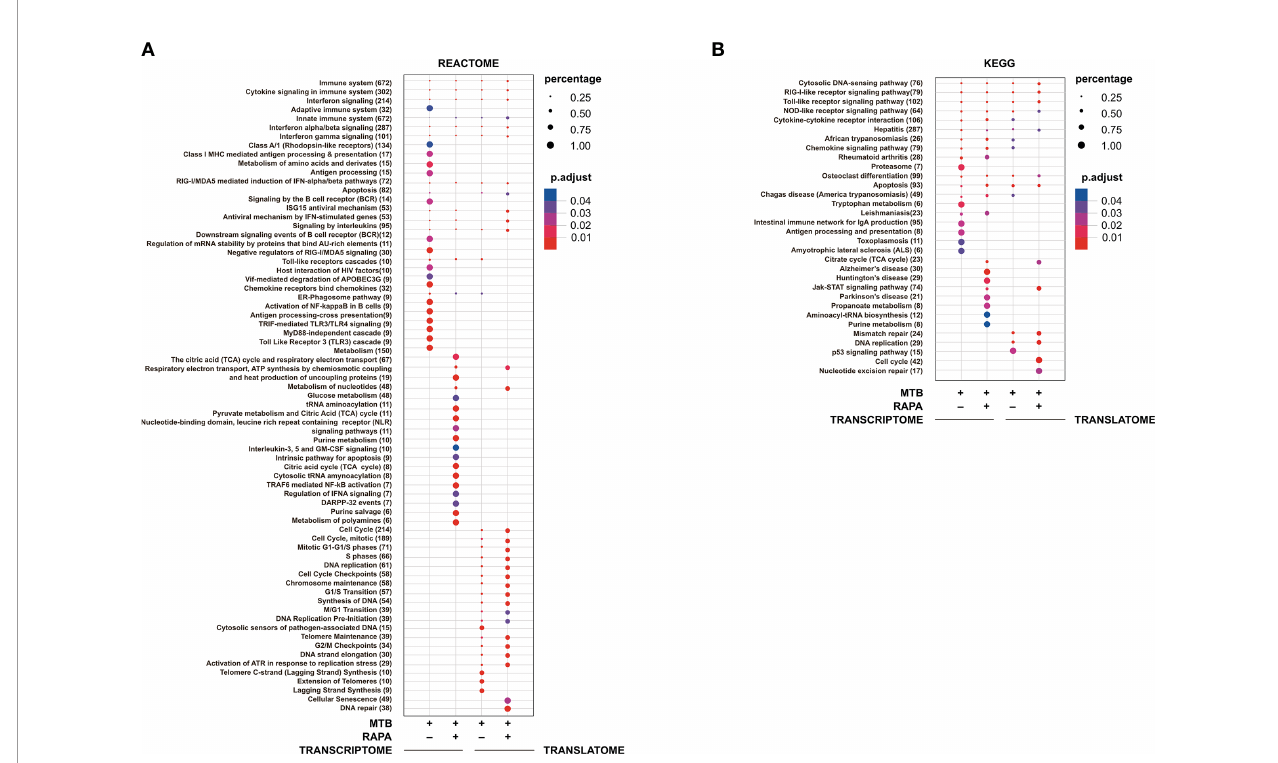
FIGURE 3 | Pathway enrichment analysis of genes modulated in transcriptome and in translatome of human DC infected with Mtb alone or in presence of rapamycin. Pathway enrichment analysis performed using Reactome (A) and KEGG (B) databases on the list of genes found de-regulated (log2 FC > 1.5; FDR < 0.01) in transcriptome and translatome of human DC infected with Mtb and treated with rapamycin. Dot size is correlated with the ratio between the total number of differentially expressed genes and the number of genes that belong to a pathway. Dots are colored according to the Benjamini-Hochberg false discovery rate adjusted p -values (p adjust) from blue (higher p -value) to red (lower p